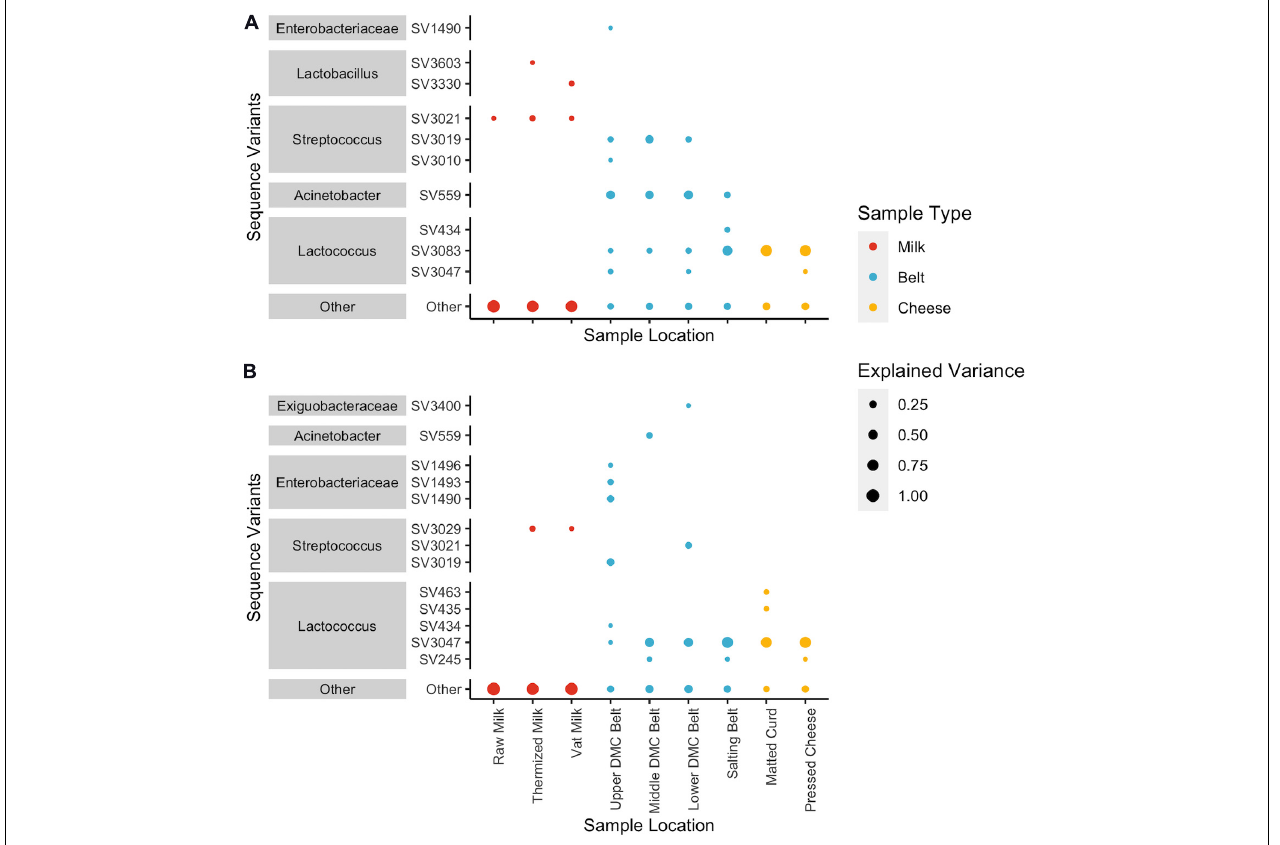
FIGURE 5 | Dot plots showing squared loadings for (A) component 1 and (B) component 2 of the location-wise principle component analyses. Dot size represents the proportion of component variance explained by each SV. Dot color represent the general sample type (i.e., milk samples: raw, thermized, and vat milk; belt samples: DMC and salting belts; and cheese samples: matted curd and pressed cheese). SVs that explain < 5% of the component variance are grouped as